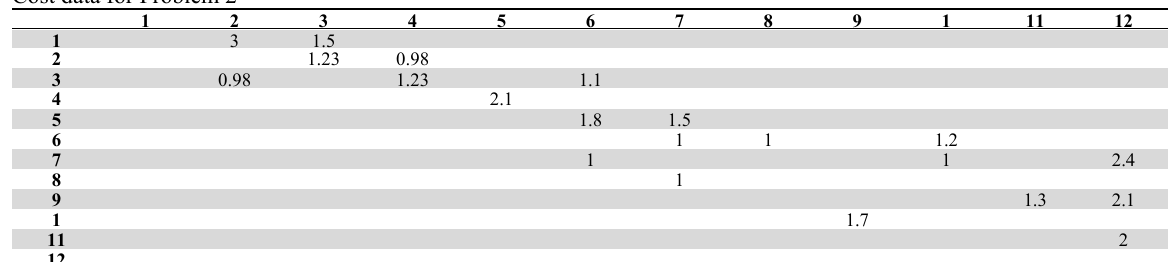
Cost data for Problem